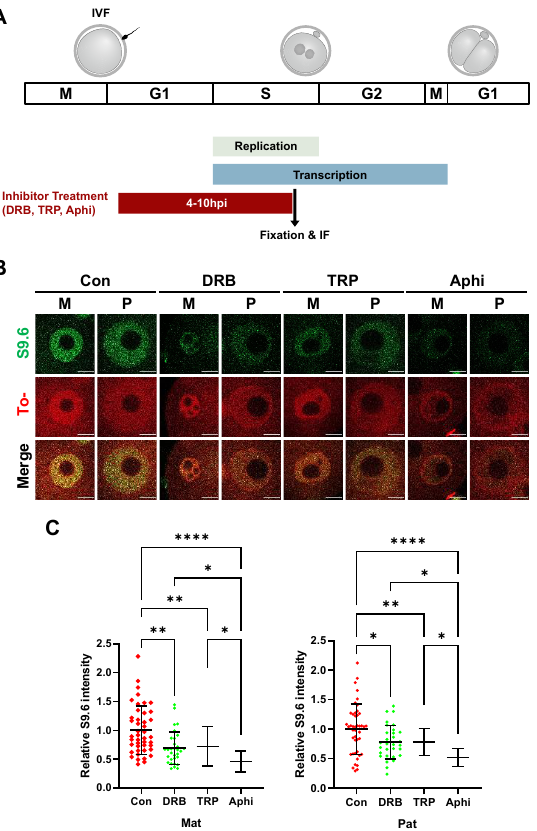
Figure 4. Zygotic R-loop levels are affected by DNA replication and transcription. ( A ) Schematic diagram of experimental design for the inhibitor treatment of transcription or DNA replication from 4 to 10 hpi (S-phase) after IVF. ZGA, zygotic genome activation; hpi, hours post – insemination; IF, immunofluorescence. ( B ) Single confocal optical section images of the maternal and paternal pronuclei. Zygotes were mock-treated (Con) and treated with 100 µM 5,6-dichloro-1- β -D-ribofuranosyl-benzimidazole (DRB), 1 µM triptolide (TRP), and 2 µg/mL aphidicolin (Aphi) from 4 hpi to 10 hpi (S-phase). Immunofluorescence detection of the R-loop (S9.6 antibodies, green), DNA (To-pro3, red), and merged images of these two channels (merged). All scale bars = 10 µM. ( C ) Quantification of relative S9.6 signal intensities in each maternal ( left ) and paternal ( right ) pronuclei. Con; n = 44, DRB; n = 31, TRP; n = 41, Aphi; n = 20. This experiment was independently replicated three times. Statistical analysis was performed using one-way ANOVA with the Kruskal-Wallis test. Error bars represent standard deviation. M, paternal pronucleus; P, paternal pronucleus. p -value: * p < 0.05, ** p < 0.01, **** p < 0.0001; center values,